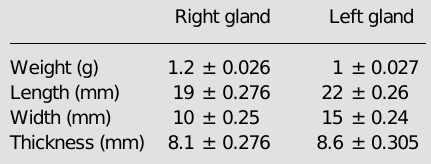
Table 1 - Weight and size of the right and left adrenal gland of viscacha. Data are reported as means ± SEM. N = 4.